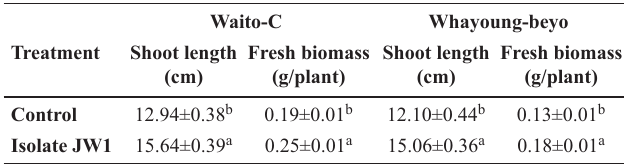
Fig. 2: Organic acids production of Bacillus subtilis JW1 after five days of incubation at 28 o C.